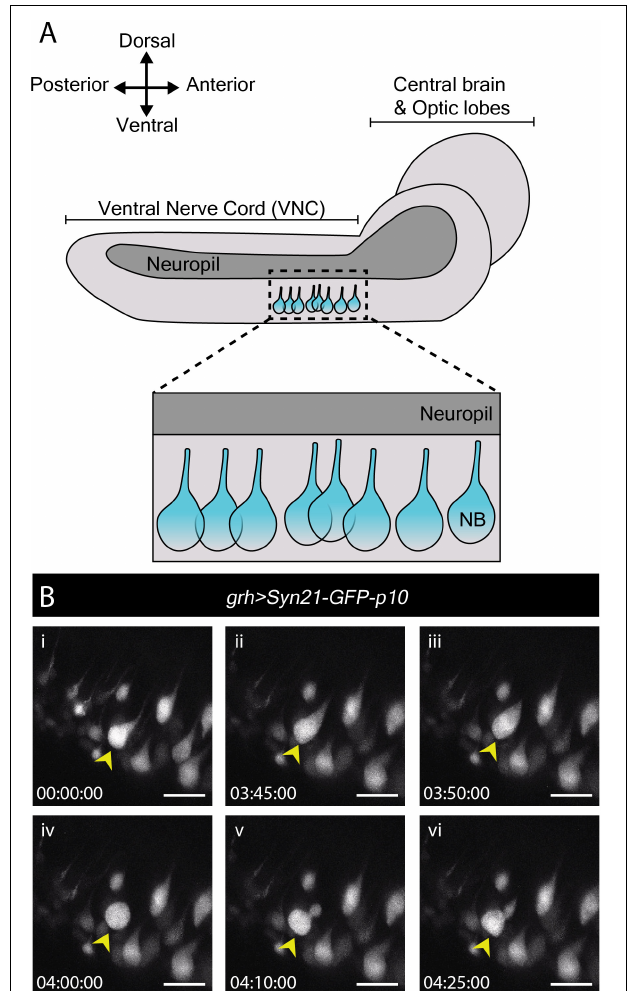
FIGURE 2 | Reactivation of quiescent neuroblasts in the L1/L2 CNS. (A) A schematic of the lateral view of an L1/L2 CNS. Neuroblasts, depicted in blue, are shown within the thoracic region of the ventral nerve chord (VNC, dashed box), the region selected for live imaging. Neuroblast (NB) cell bodies are situated on the ventral side of the VNC. During quiescence, they extend a fiber toward the neuropil. Upon reactivation, which occurs roughly 24 h after larval hatching for neuroblasts in the thoracic VNC, neuroblasts lose their fiber, which marks a relatively early morphogenetic event we sought to capture through our live imaging protocol. (B) A time-series extracted from Movie 2 of a cultured grh > Syn21-GFP-p10 brain (L1/L2) showing an example neuroblast in the VNC (yellow arrowhead), which reactivates first by moving dorsally, then rounding before undergoing an asymmetric division to produce a dorsally positioned GMC. Timescale displayed as hh:mm:ss, scale bar = 10 µ m.